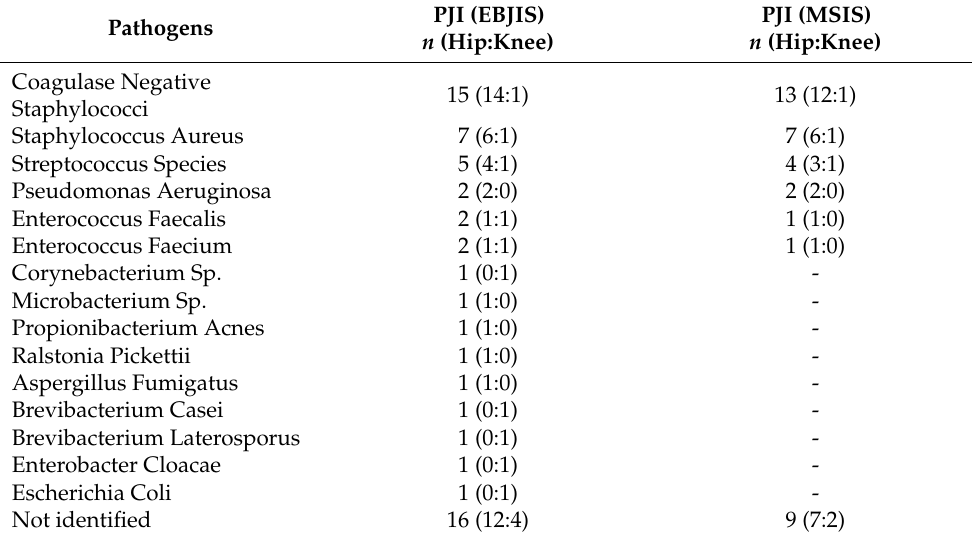
Table 3. Pathogens isolated at the microbiological analysis after total hip or knee arthroplasty revision.